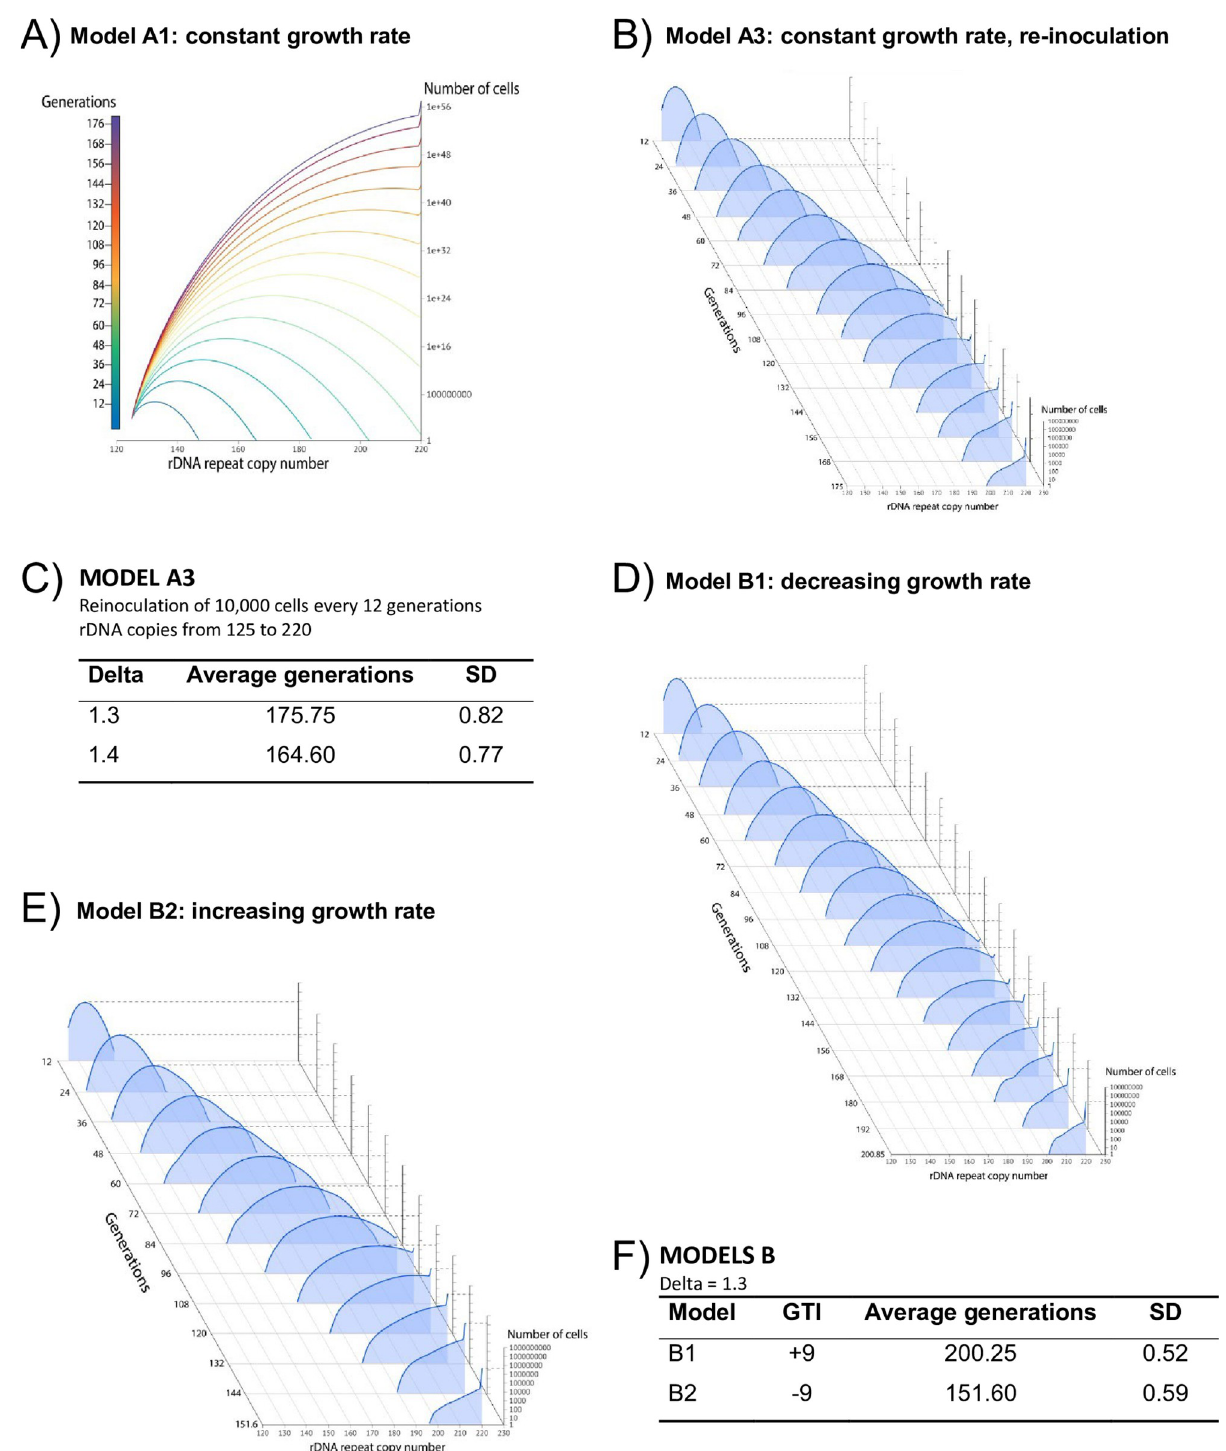
Fig 2. Cellular automaton model accurately predicts the experimentally observed evolution of early cln3 . A) Model A1 shows the predicted evolution during the generations of the cell population according to the scheme shown in S1 Fig. Population curves are shown only for multiples of 12 generations up to the generation where > 98% of cells have 220 repeats. B) Model A3 shows the predicted evolution for the re-inoculation of 10000 cells every 12 generations. This model has a stochastic parameter that produces variation during each program run. C) A summary of the results obtained with Model A3 after 10 runs. Average and standard deviations (SD) are shown for the increased parameter per generation (Delta) of 1.3 and 1.4. D, E)